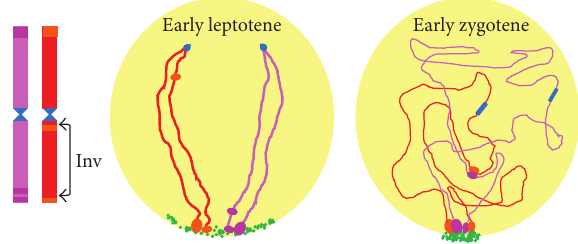
F 4: Diagrammatic representation of two homologous chro- mosomes with an inversion (inv) in heterozygous condition, in early meiosis. e positional change of a heterochromatic chromo- mere from distal to proximal denotes the length of the inversion. e normal and inverted homologous arms show an antiparallel orientation in early leptotene. In early zygotene, the subdistal chromomere of the normal arm pairs with its proximal counterpart in the inverted chromosome aer movements concurrent with chromosome